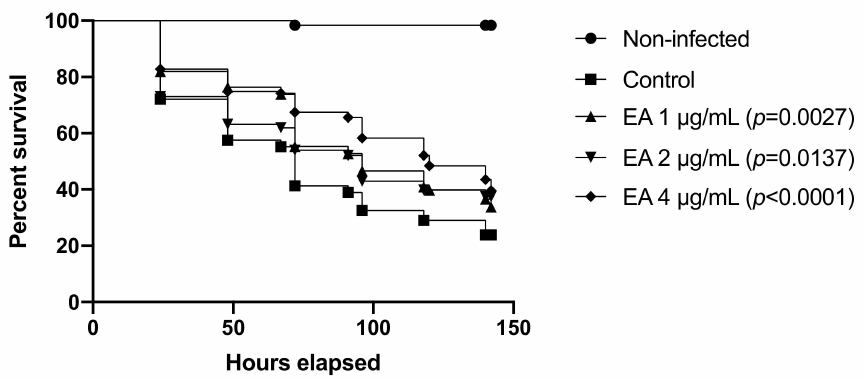
Figure 8. Kaplan–Meier survival curves of infected C. elegans . EA protects C. elegans larvae from C. albicans infection after 150